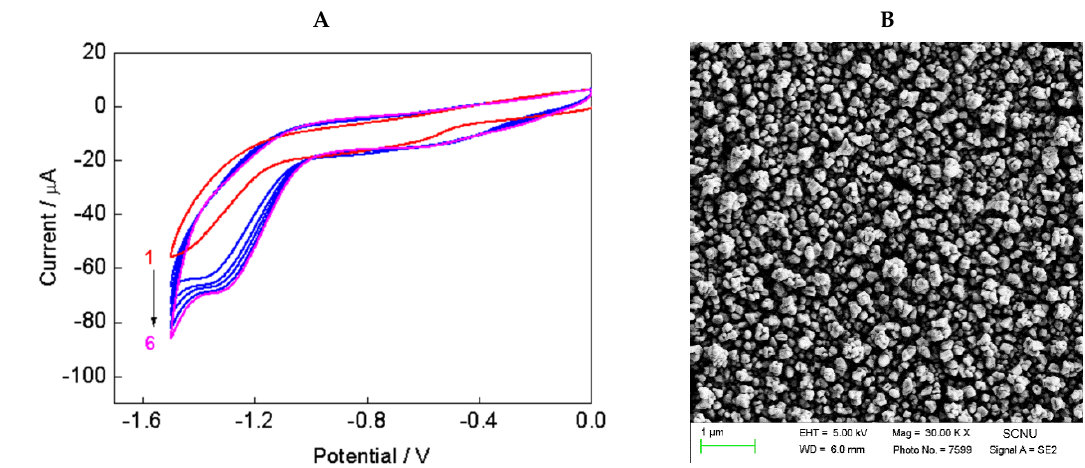
Figure 2. Cyclic voltammograms (CVs) of bare glassy carbon electrode (GCE) in pyrrole/graphene oxide solution for 10 cycles with a scan rate of 25 mV/s ( A ) and typical SEM image of polypyrrole (PPy)/graphene oxide (GO) ( B ).